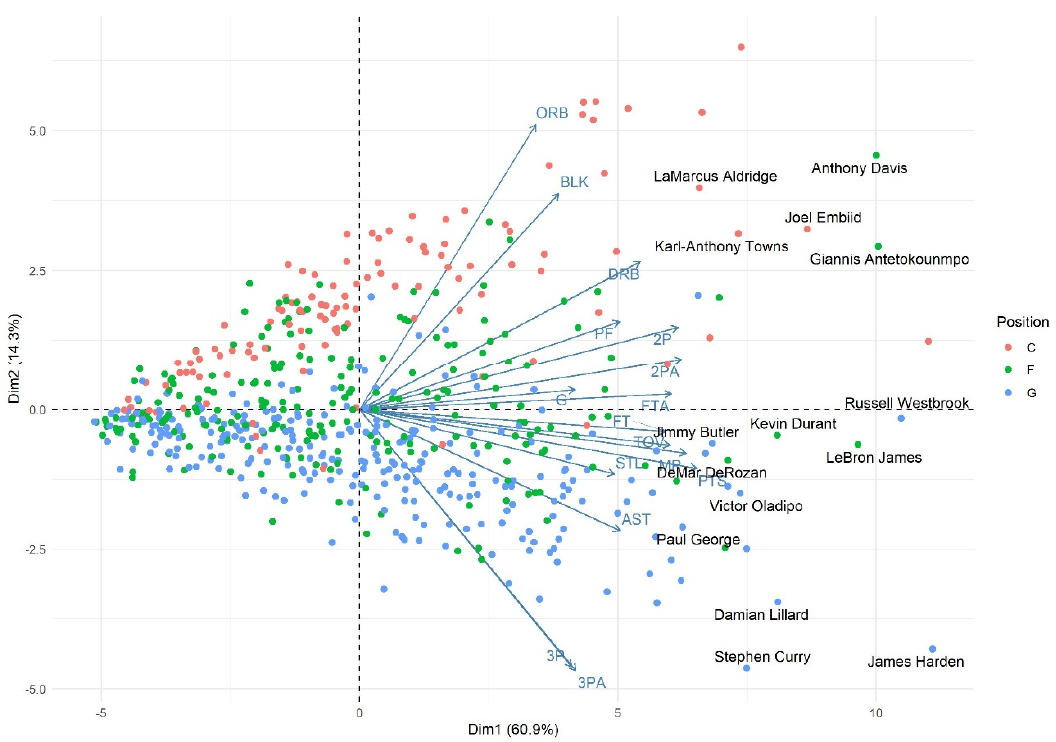
Figure A5 . Principal Component Analysis of active players in the 2017–18 NBA Season.